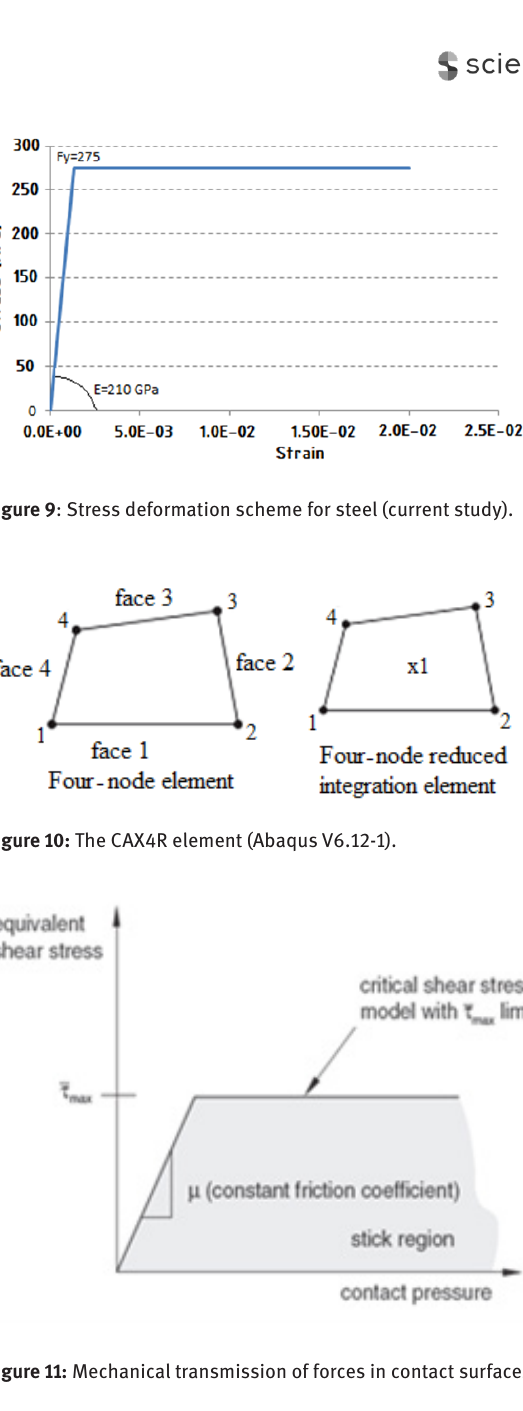
Figure 11: Mechanical transmission of forces in contact Figure 10: The CAX4R element (Abaqus V6.12-1)